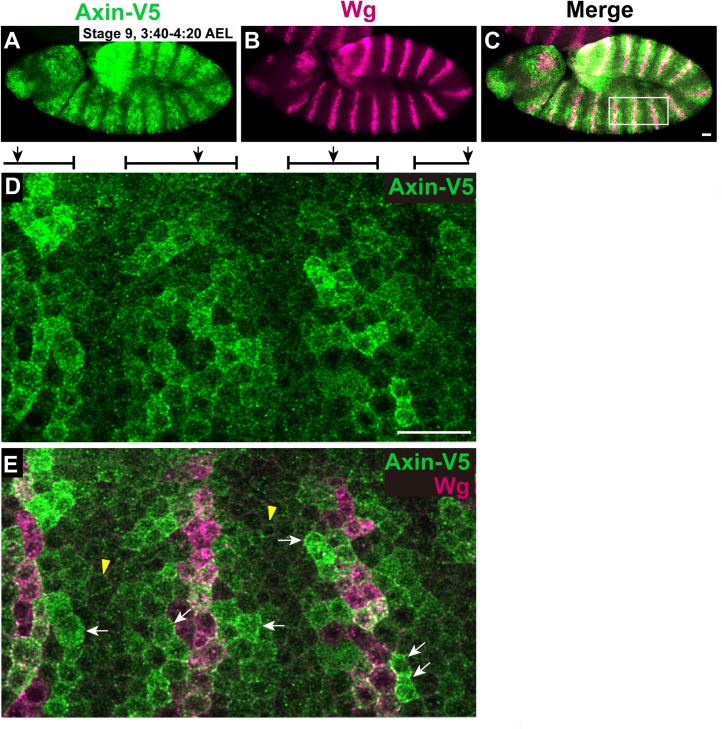
Axin levels are increased in the cytoplasm and at the plasma membrane following Wingless exposure.Confocal images of embryos expressing Axin-V5 driven by the mat-Gal4 driver stained with V5 (green) and Wingless (Wg, magenta) antibodies. Anterior left, dorsal up. (A-C) By 30 minutes after the onset of Wg expression (stage 9), Axin-V5 increases in segmental stripes both at the plasma membrane and in the cytoplasm. (D and E) Higher magnification of boxed region in panel (C). Axin-V5 is distributed in wide segmental stripes (brackets on top) that overlap the Wg stripes (black arrows on top). Cells surrounding the Wg stripes display increased Axin intensity that is present at both the cell membrane and within the cytoplasm (white arrows) compared with cells between neighboring Axin stripes (yellow arrowheads). Axin is present in puncta at the cell periphery even in the absence of Wingless (yellow arrowheads). Scale bars: 25 μm.